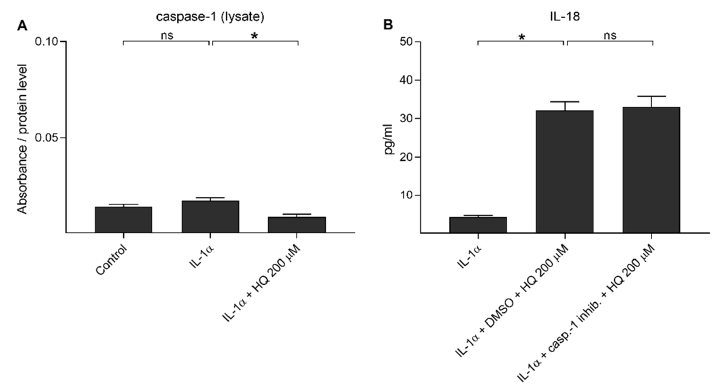
Figure 4. The effect of 200 µ M hydroquinone (HQ; 18 h) on the cleaved caspase-1 (p20) levels detected from cell lysate ( A ) samples and the effect of caspase-1 inhibitor (casp.-1 inhib.; 20 µ M in DMSO 0.22% v/v ) on the hydroquinone-induced IL-18 release ( B ) in IL-1 α -primed ARPE-19 cells. Absorbance values in ( A ) were 0.225–0.288 in the control, 0.259–0.379 in the IL-1 α , and 0.149–0.161 in the IL-1 α +